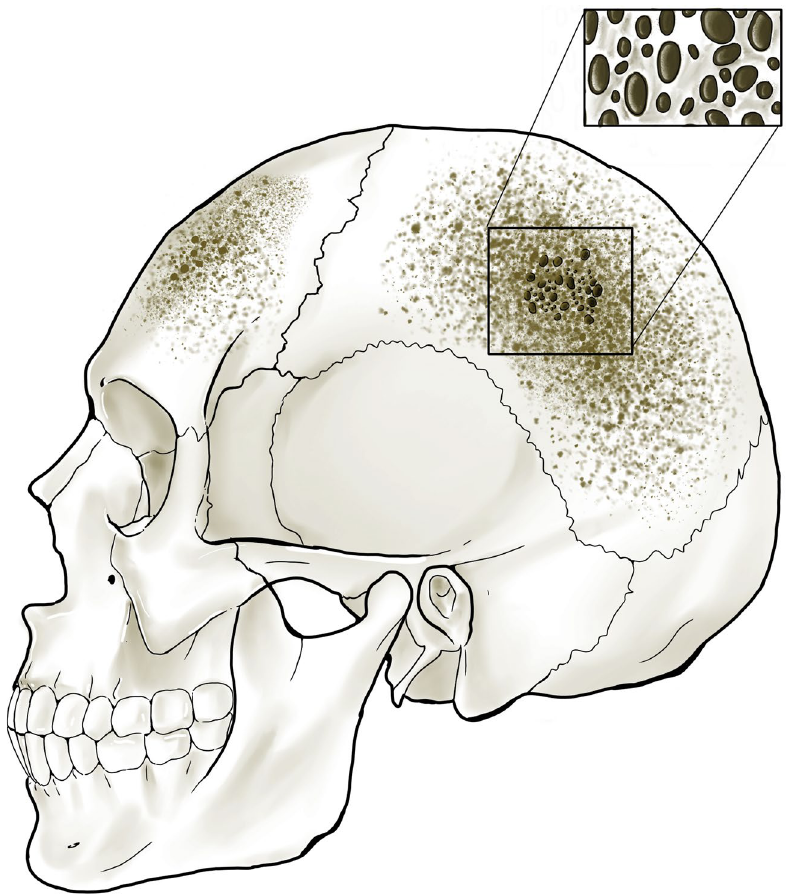
Figure 1. Porotic hyperostosis is characterised by thicker skull bones with an increased porous area caused by an expansion of the cranial diploë.